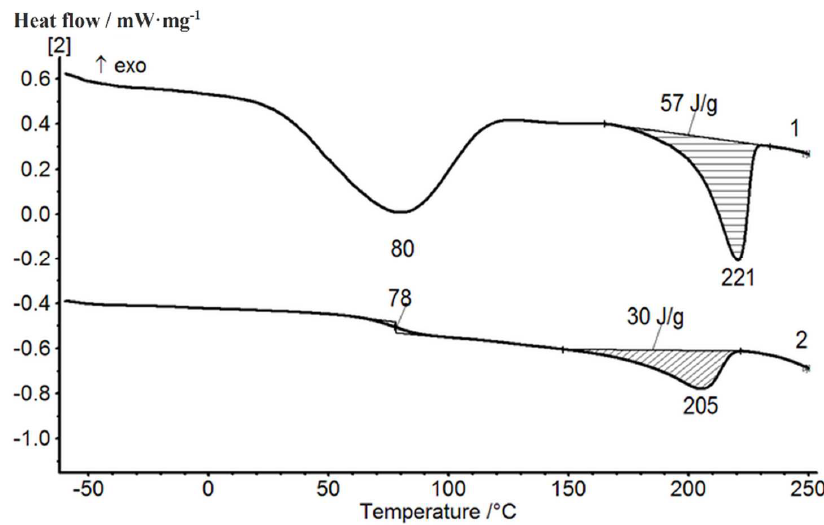
Figure 9. First and second DSC scans of the 90/10 (wt./wt.) PVA–pDMAEMA composition.